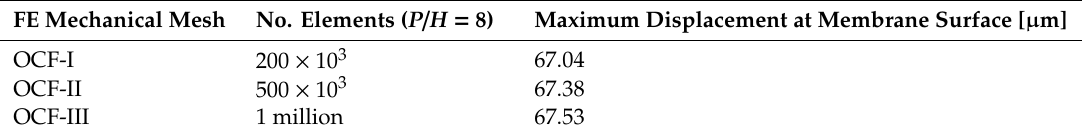
Table 3. Grid dependence results (TMP = +0.8 bar).